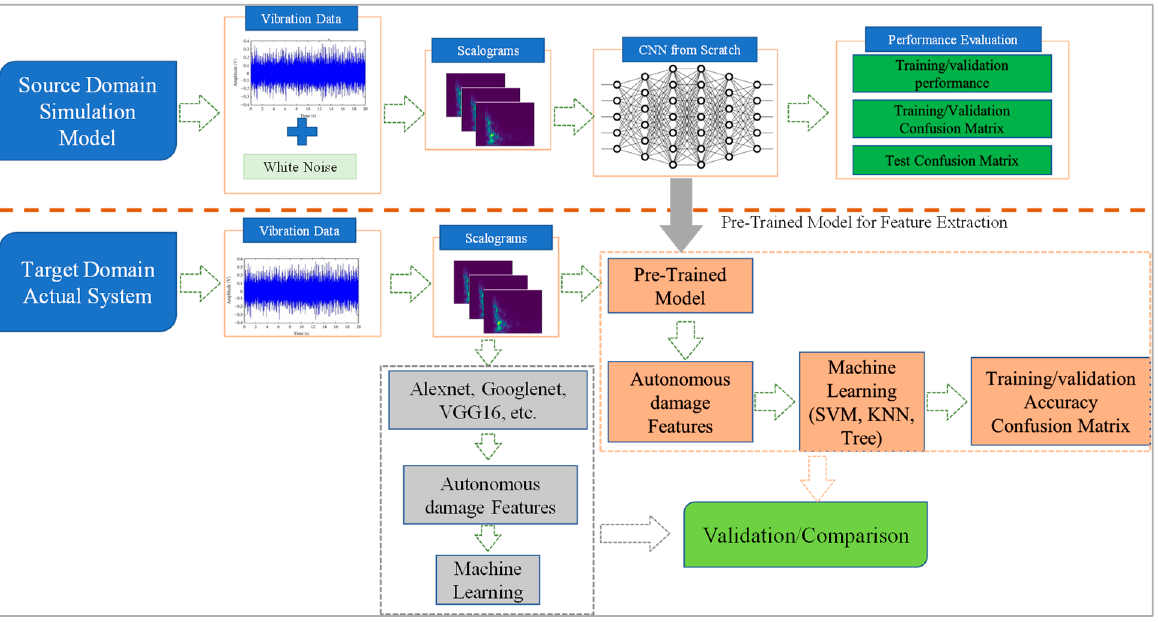
Figure 2. Overall workflow of the proposed methodology.